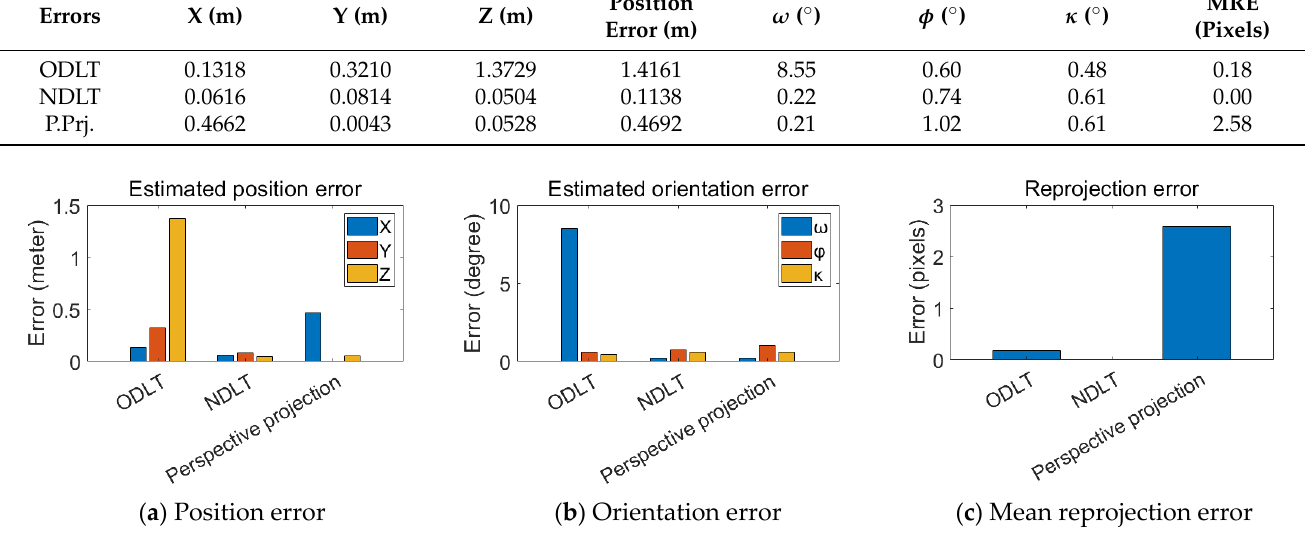
Figure 13. Estimated EOP error ( a , b ) and mean reprojection error ( c ) for a smartphone.